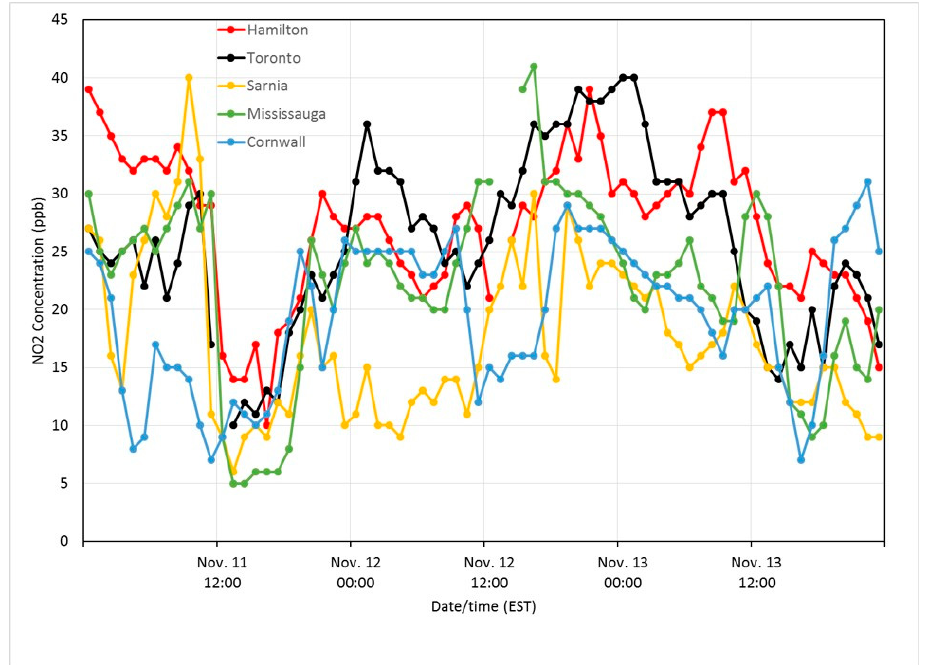
Figure 13. NO 2 hourly concentrations at various locations, 11–13 November 2010.